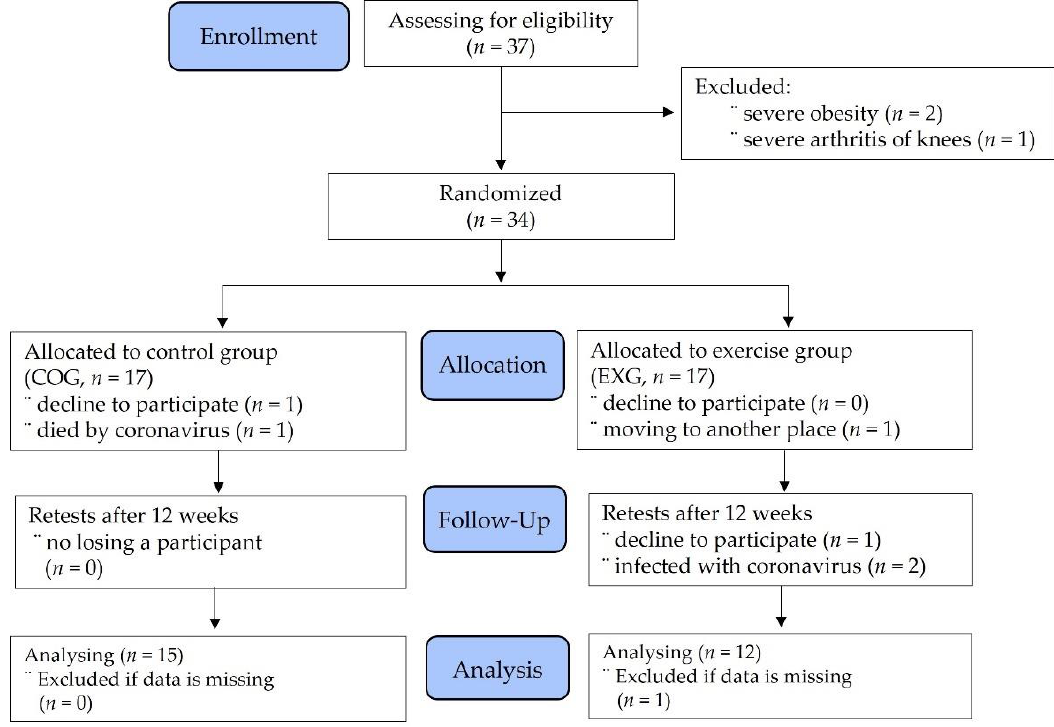
Figure 1. Participants’ allocation (consolidated standards for reporting of trials flow diagram).